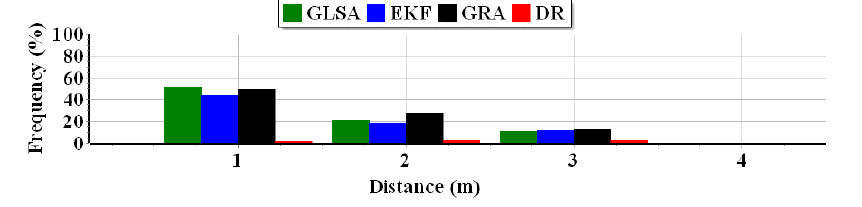
Figure 23. Arithmetic mean of the percentages of the distance to the reference point from the estimated point during 100 SV crossings.